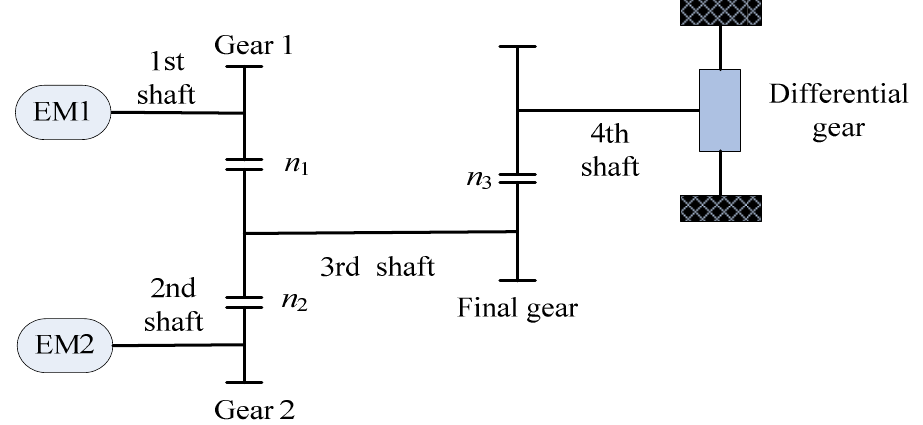
Figure 1. Layout of powertrain with